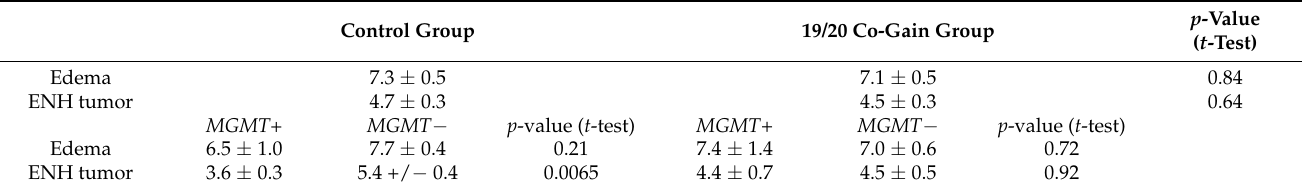
Table 3. Tumor size. Mean maximum of tumor edema and enhancing region (ENH) in cm. Values are shown for MGMT methylated (MGMT+) and unmethylated (MGMT − ).